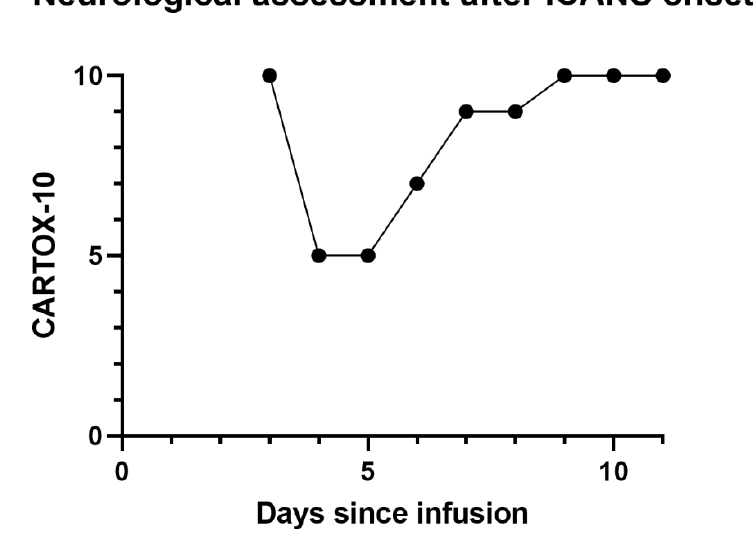
Figure 3. CARTOX-10 score since development of ICANS until discharge.